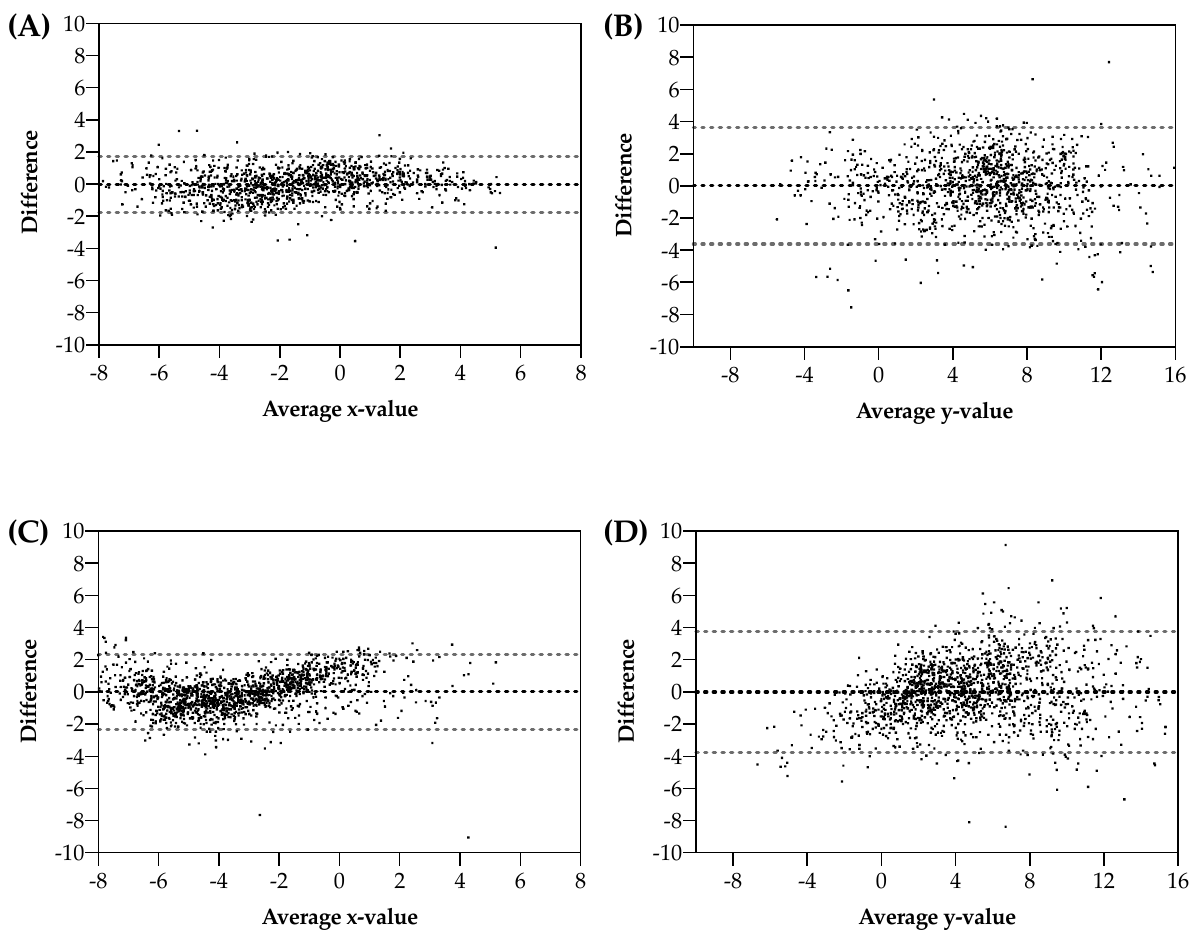
Figure 2. Agreement between (Bland–Altman plots) results obtained by the Heath–Carter method and resulting from multiple linear regressions for x- and y-axis, stratified for male (above, panels ( A , B )) and female (below, panels ( C , D )) subjects.